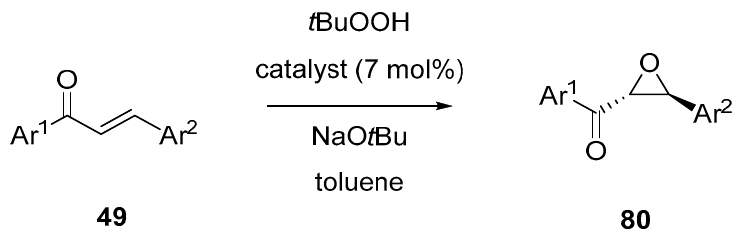
Table 13. Effect of crown ethers in the epoxidation of chalcones ( 49